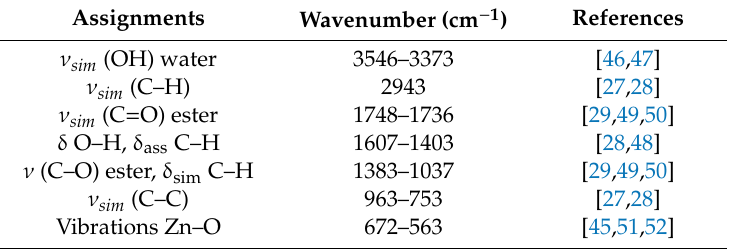
Table 1. Assignment of the FTIR absorption bands observed in the present